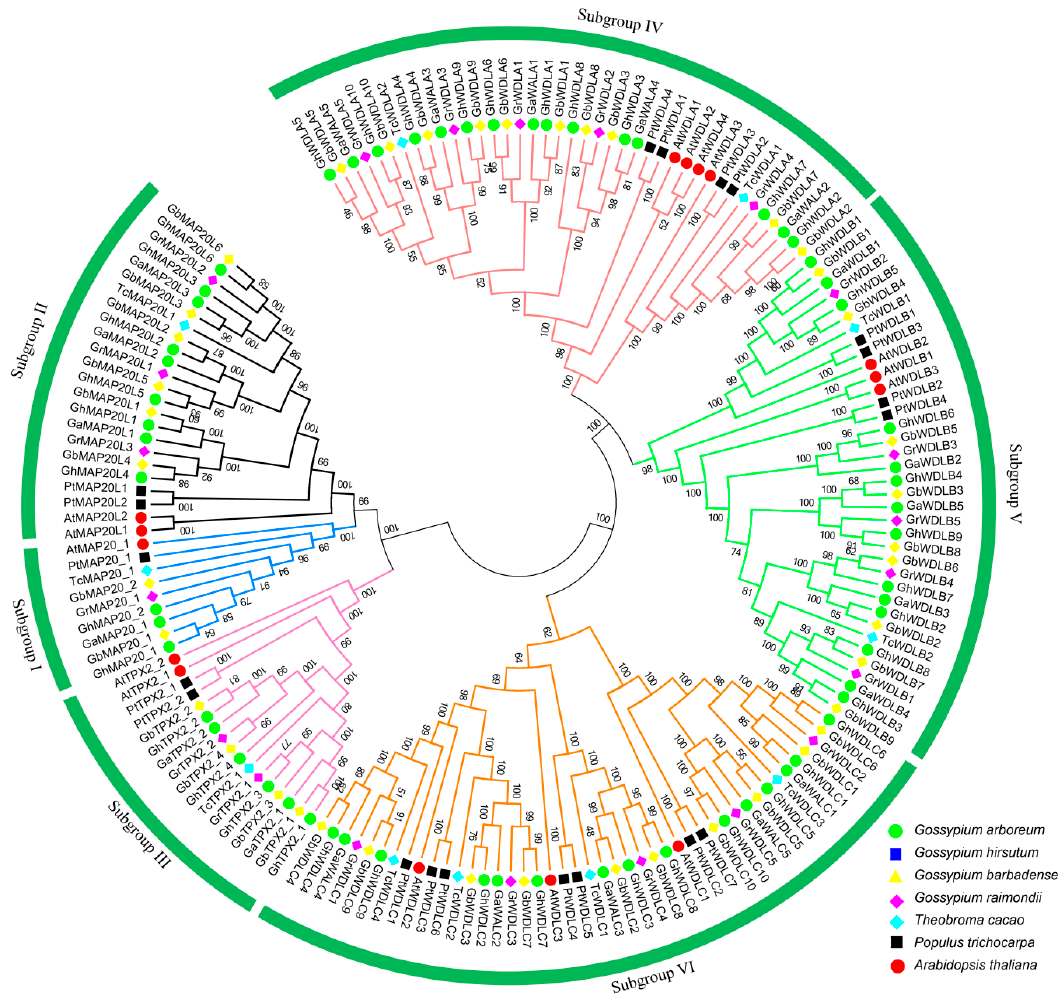
Figure 1. Neighbor-joining phylogenetic tree of TPX2 proteins from different plant species Gossypium hirsutum , Gossypium arboreum , Gossypium barbadense , Gossypium raimondii , Arabidopsis thaliana , Populus trichocarpa , and Theobroma cacao .